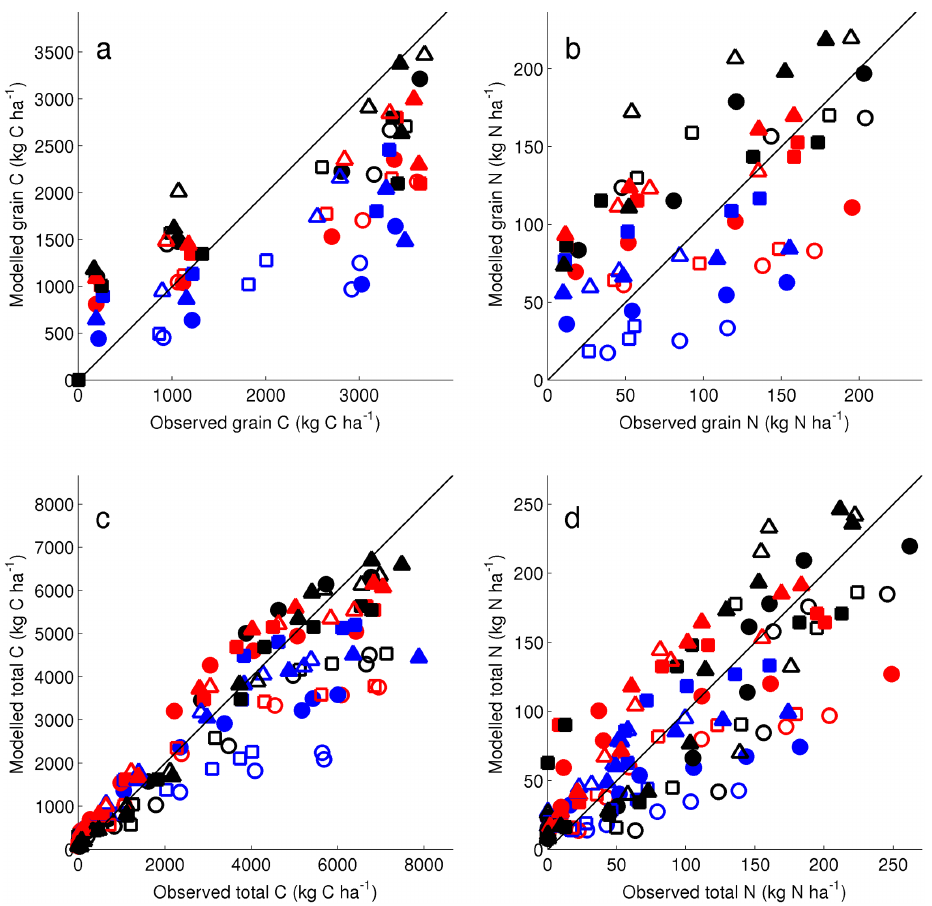
Figure 3. A comparison between modelled and observed grain C (a) and N (b) , and total biomass C (c) and N (d) for the Eest, the Bouwing and PAGV, the Netherlands over the growing-seasons 1982–1983 and 1983–1984. Symbols are the same as in Fig. 2 with blue symbols for low input of N fertiliser, red for a medium input of N and black for high N input.